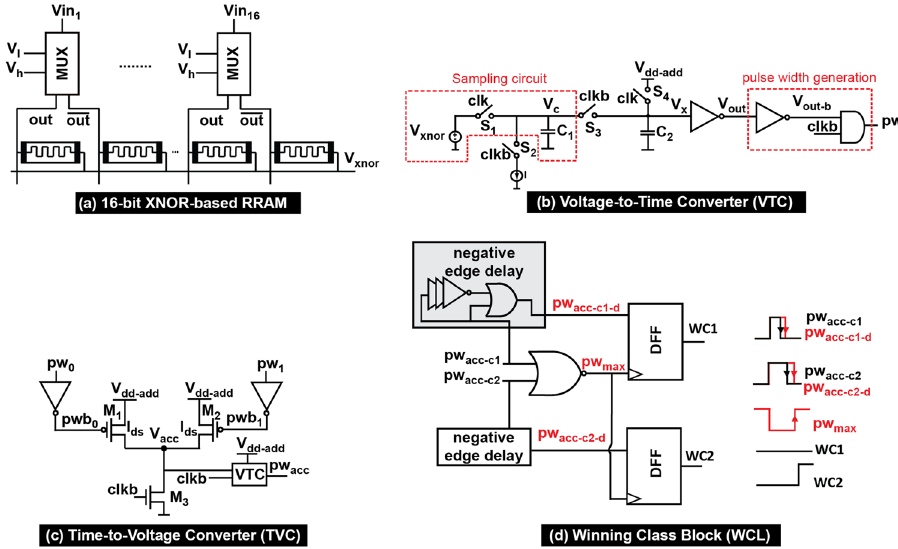
Figure 3. Circuit designs of the proposed RRAM-based CAM, analog time-domain adder and winning class logic. ( a ) 16-bit XNOR-based RRAM, ( b ) proposed VTC circuit, ( c ) TVC circuit and ( d ) digital winning class logic.